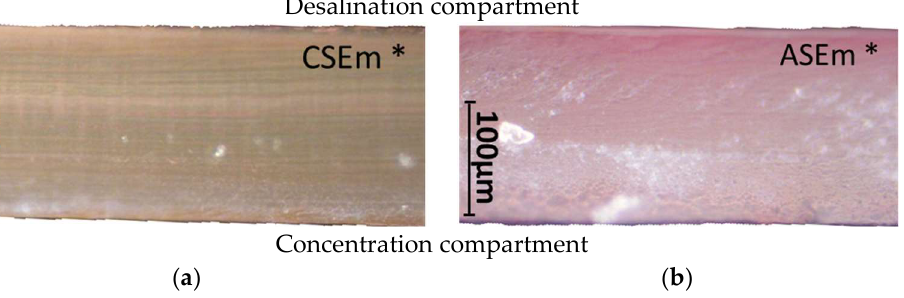
Figure 11. Optical images of cross sections of modified CSEm * ( a ) and ASEm * membranes ( b ) after ED processing of model solution. “Desalination compartment” and “Concentration compartment” indicate the chambers bordering the membrane surface. The cross section of the ASEm * membrane was placed in acidic solution before imaging to make the presence of anthocyanins more evident.